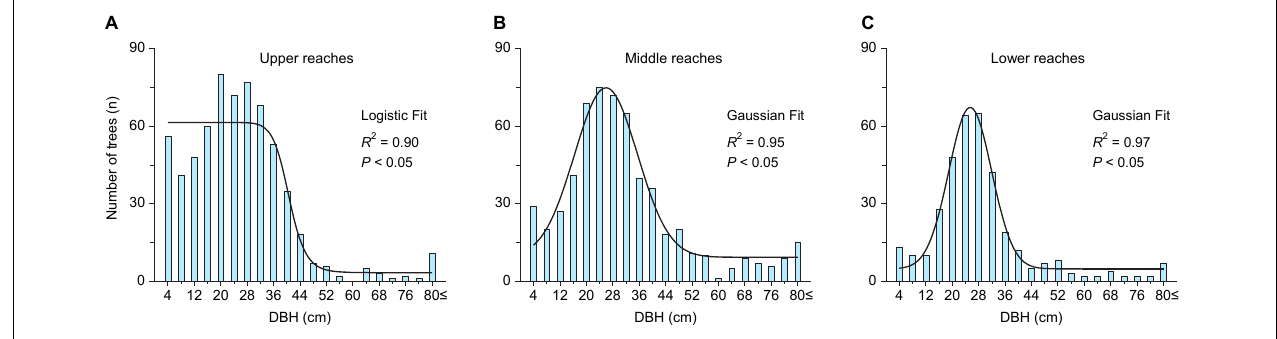
FIGURE 4 | The number of P. euphratica trees in different DBH classes in the three transects of the Tarim River. The black line represents the curve fit of the nonlinear regression analysis. The results were significant at the 0.05